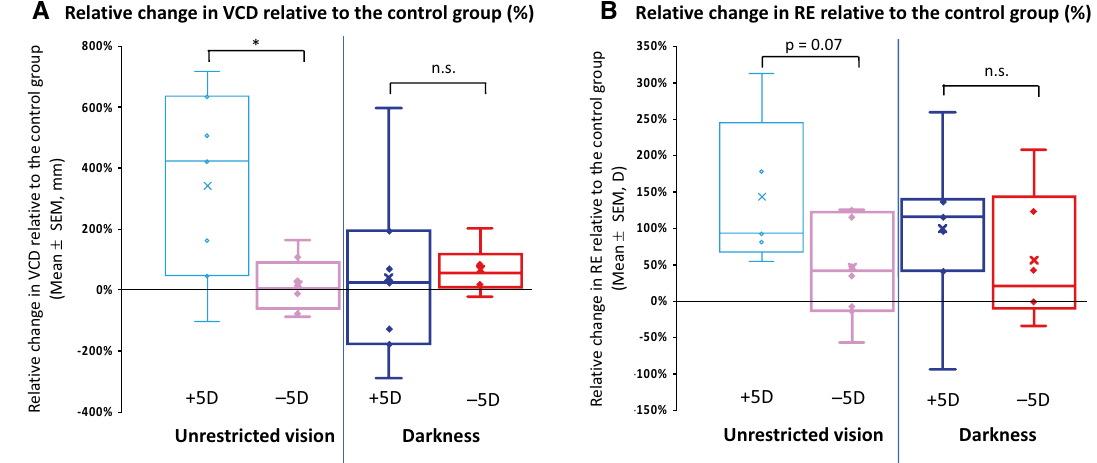
Figure 5. The percentage change between the groups with interrupted lens wear and the control group (the ratio between relative change in an interruption group and that in the control group) for vitreous chamber depth (VCD, A ) and refractive error (RE, B ). n.s. Not significant; *p <